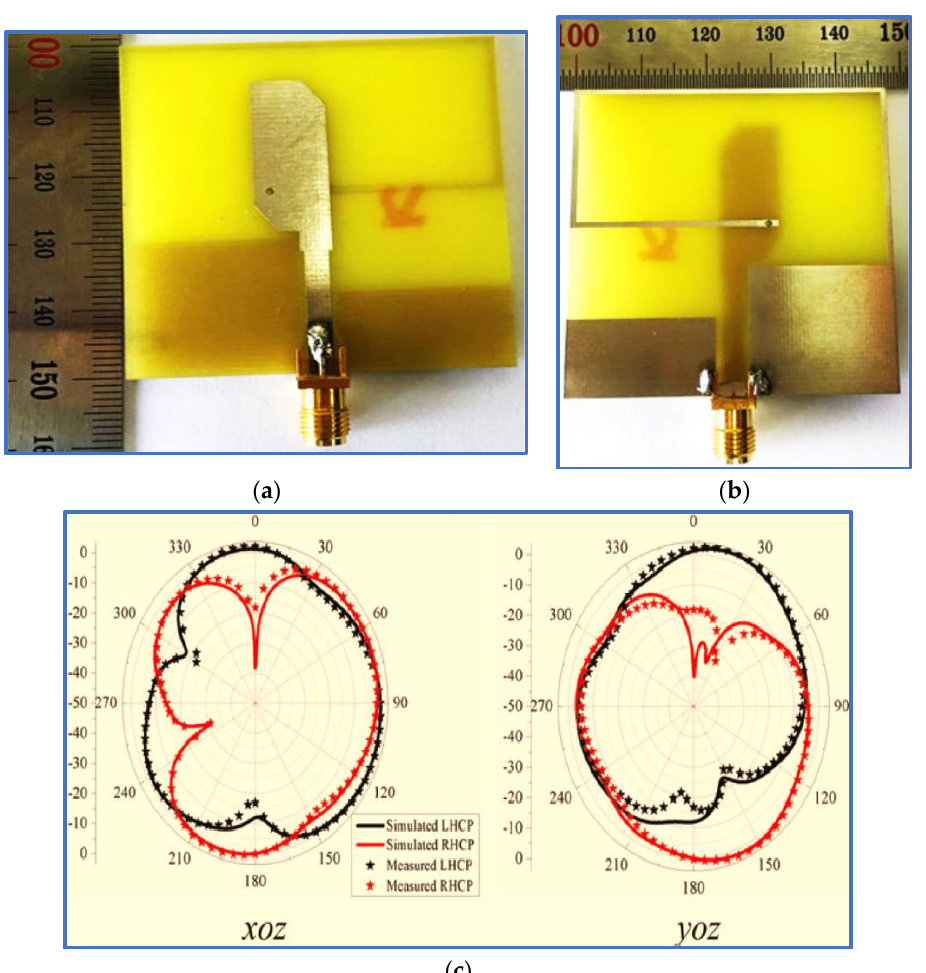
Figure 25. A modified rectangular monopole antenna: ( a ) front side; ( b ) back side; ( c ) normalized radiation pattern at 4.7 GHz [134].